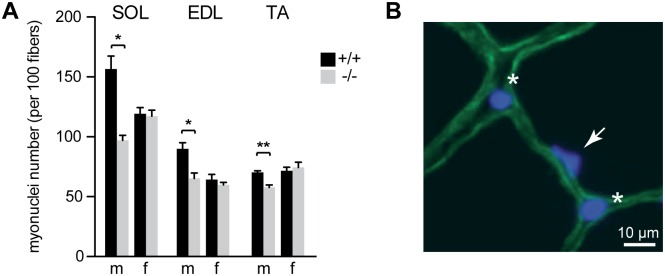
Myonuclei number in 12 week old SynB-/- mice.(A) Quantification of the myonuclei number per 100 fibers in SOL, EDL and TA muscles of WT and SynB-/- male and female mice. The number of myonuclei was estimated by analyzing at least 300 myofibers for each condition. Data are the mean ± SEM (4–6 mice analyzed per sex and per genotype; * p<0.05, ** p<0.01, Mann and Whitney test). (B) Nuclei corresponding to myonuclei (white arrow) are located within the myofibers. Nuclei outside myofibers (white asterisk), including those from satellite cells, were not counted.